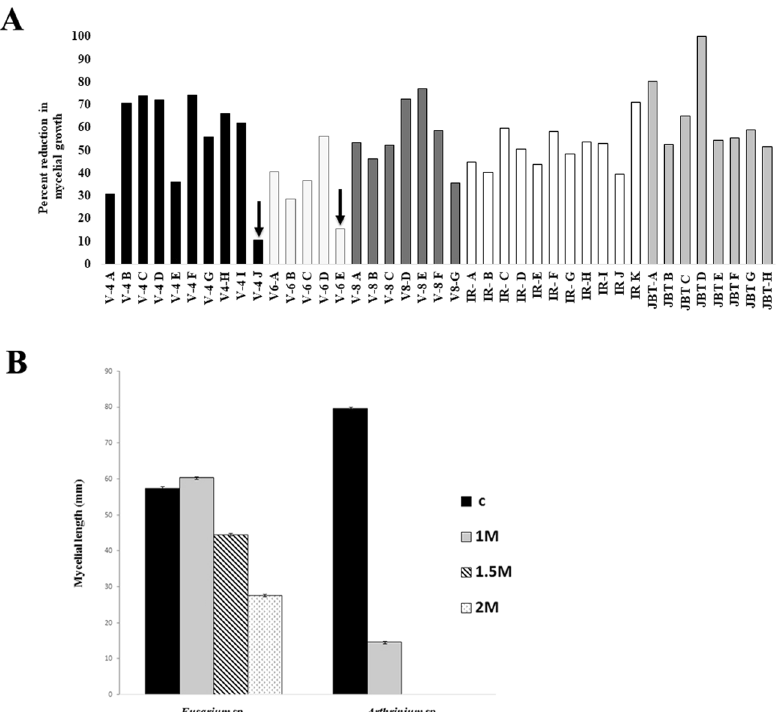
Figure 1. Mycelial growth: ( A ) Percent reduction in mycelial growth of 41 OTUs from salt adapted and sensitive genotypes subjected to 1 M NaCl. Arrow indicates highly salt tolerant OTUs. (V-4, V-6 and V-8 refer to isolates from Pokkali rice land races VTL-4, VTL-6 and VTL-8 respectively. IR refers to the isolates from IR-64 and JBT refers to isolate from JBT 36/14). ( B ) Mycelial growth of endophytic fungi, Fusarium sp ., and Arthrinium sp. at different concentration of NaCl. Line over bars denote SD( ±